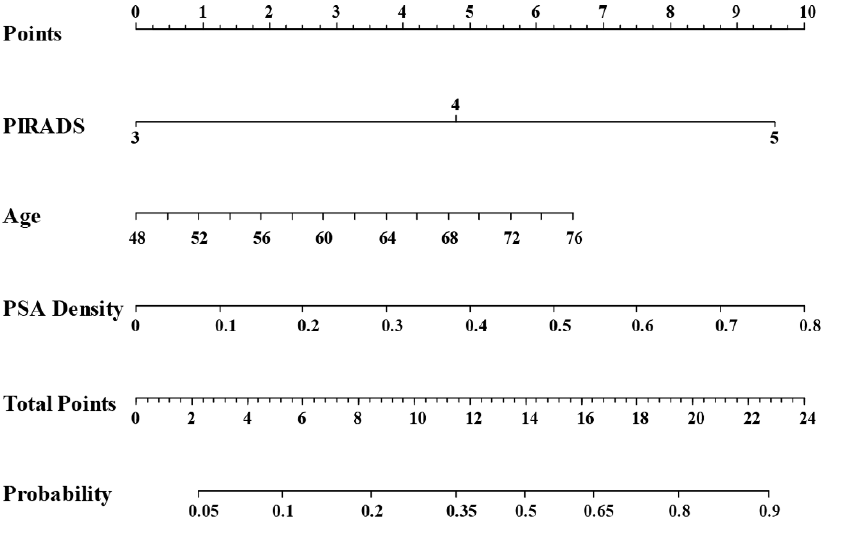
Figure 5. Model calibration plot for observed and predicted probability. 3.4. Decision Curve Analysis The outcomes of the decision analysis curve are shown in Figure 6. The net benefit of performing SB in addition to TB on all cases is depicted by the grey line, whereas the black line represents the net benefit of not performing SB (only TB performed). To avoid the harm of unnecessarily intervening on the patients who are disease free and over interven- ing in the patients with disease, the net benefit of performing SB in addition to TB based on our prediction model with a reasonable range of threshold probabilities is shown as a red line in Figure 6. The net benefit of using our prediction model is to identify patients at risk of having csPCa who will benefit from SB in addition to TB. Our nomogram increased